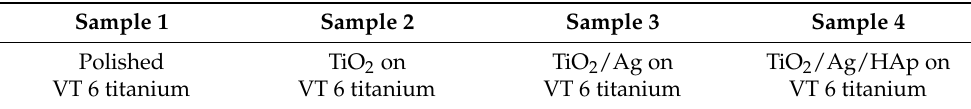
Table 1. Samples for cytological studies.